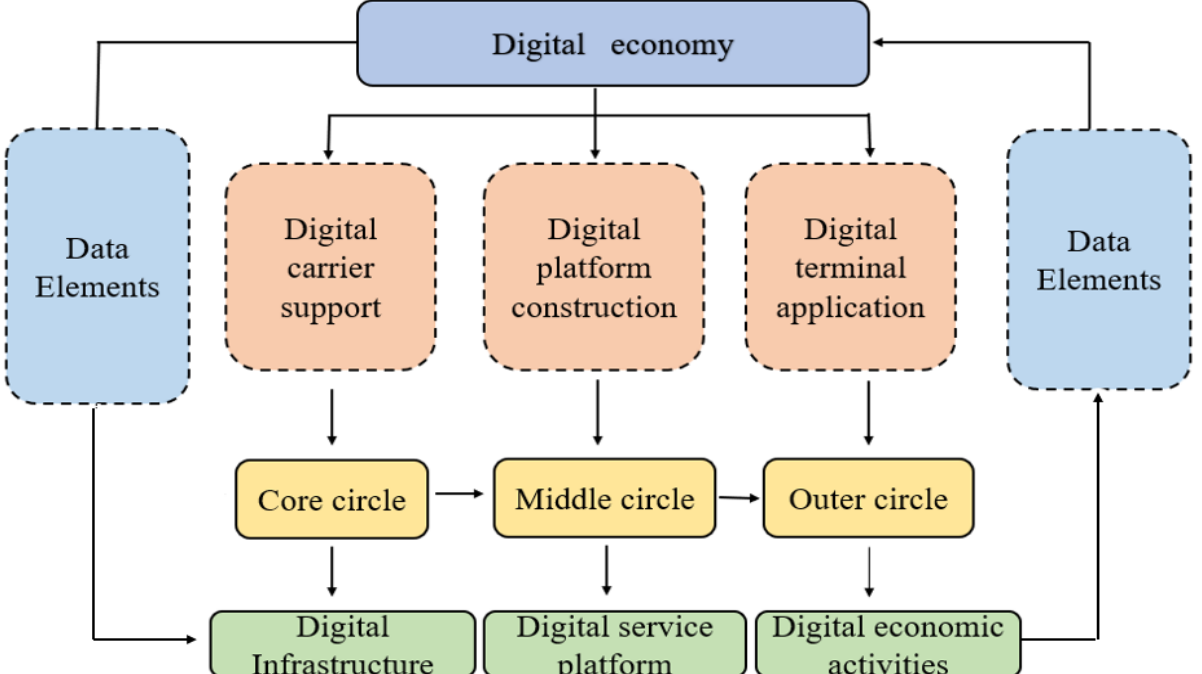
Figure 1. Logic framework of digital economy measurement. Source: Figure 1 made by the author.